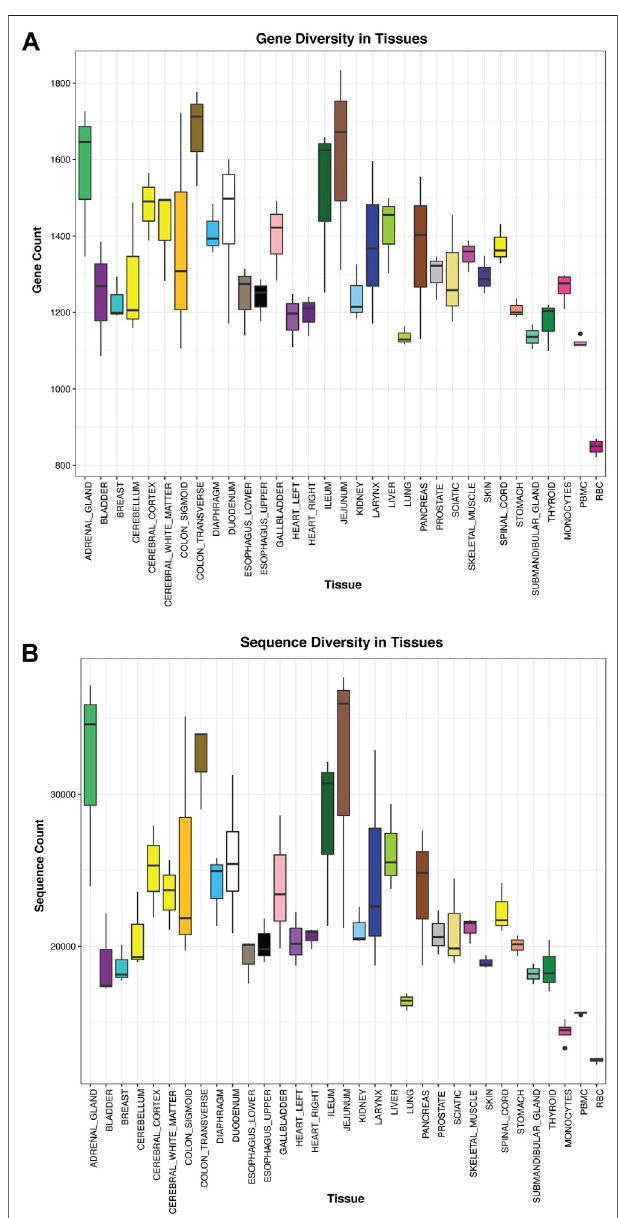
FIGURE 4 | Tissue Diversity. Panel (A) displays the number of genes detected using small RNASeq in each tissue. In this case, all isomiRs, isoforms, and fragments are collapsed to the parent gene and counted once. InPanel (B) ,alluniquesequences, isomiRs,isoforms,andfragmentsare counted separately and summed